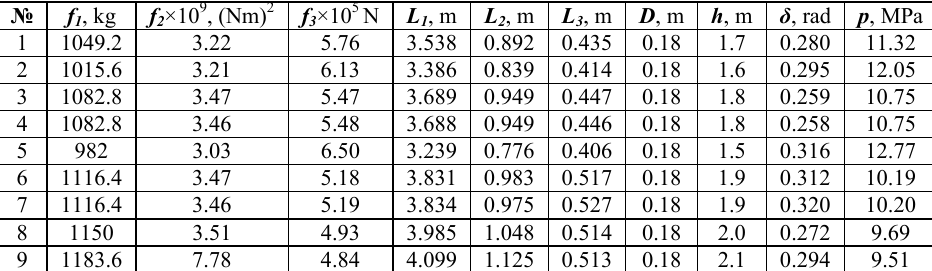
Table 7. Pareto optimal solutions - Stage